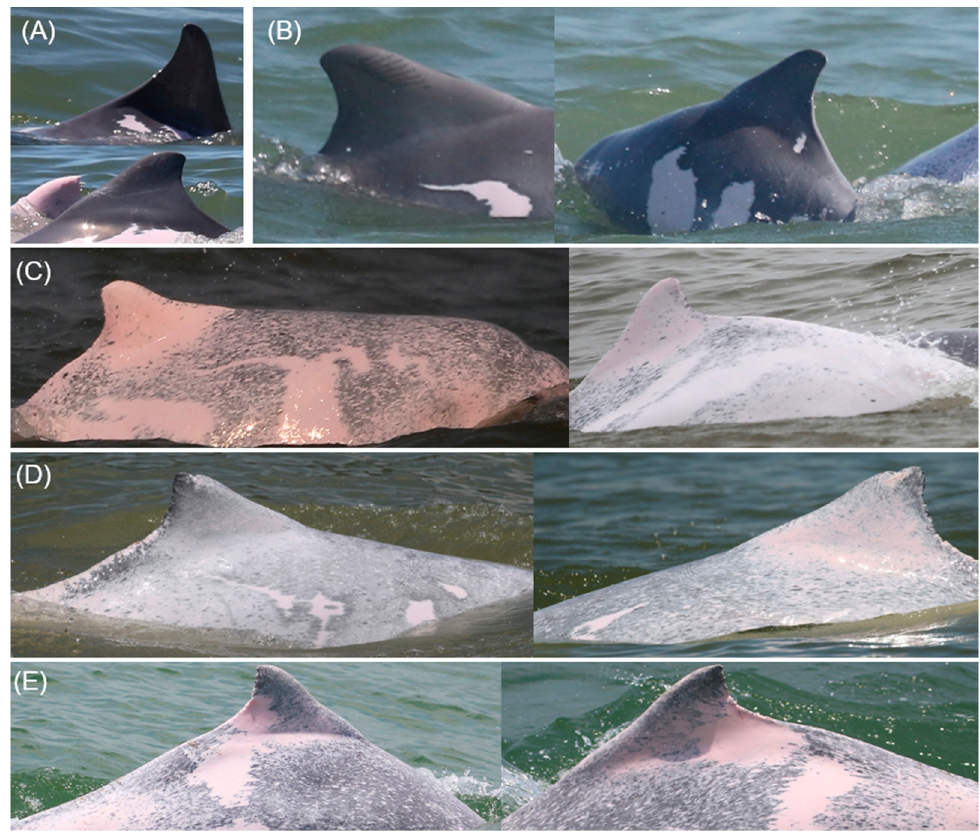
Figure 3. Examples of the hypopigmentation cases in young and adult Indo-Pacific humpback dolphins. Each panel represents the two body sides of the same individual. ( A , B ) Hypopigmentation on both sides of two calves < six months old; ( C–E ) hypopigmentation on both sides of three